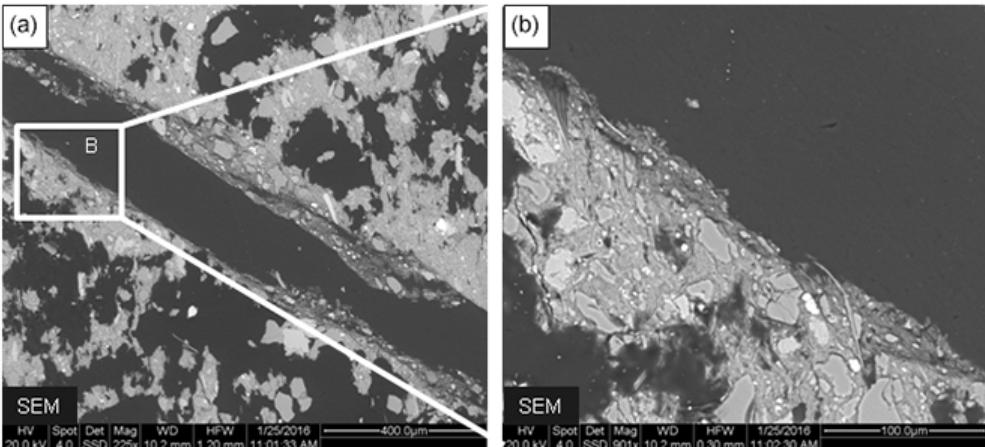
Figure 13. Very-high-resolution close-up of the mylonitic zone located in the shear failure area. It can be clearly observed how the particles have been pulled apart from the original matrix material and rearranged near the